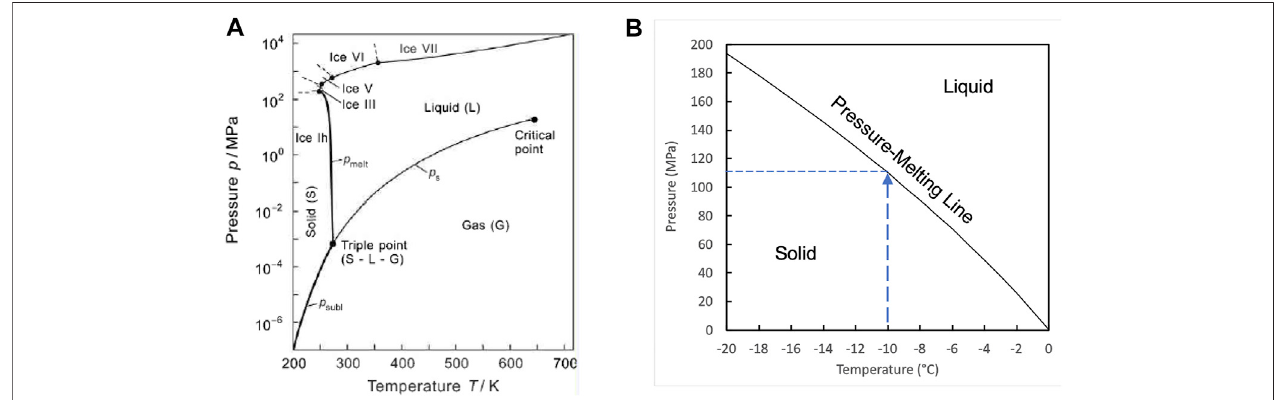
FIGURE3|(A) P(T) phasedaigramforwater(reproducedfromWagneretal.,2011,withthepermissionofAIPPublishing).Hexagonal-structureIceIhistheonlyice phasestableonEarth ’ ssurface. (B) Equilibriumpressure-meltinglineforIceIh(from Eq.6 inWagneretal.,2011).Forexample,inceasingpressureto110 MPawillcause ice to melt at − 10 ° C with the requisite addition of